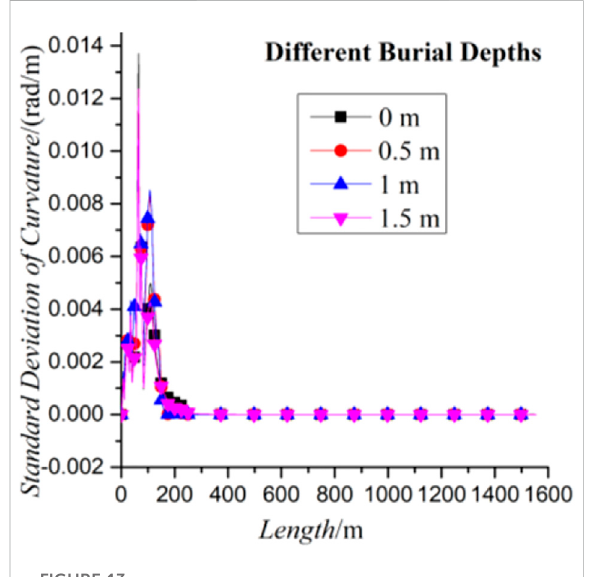
FIGURE 13 Standard deviation of the curvature of the pipeline in the length direction with different burial depths.